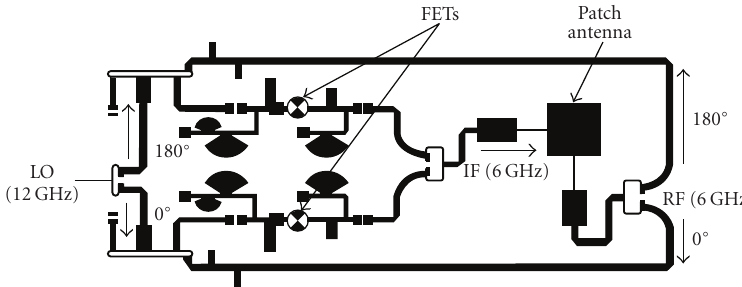
Figure 3: Schematic diagram of active phase-conjugating element.